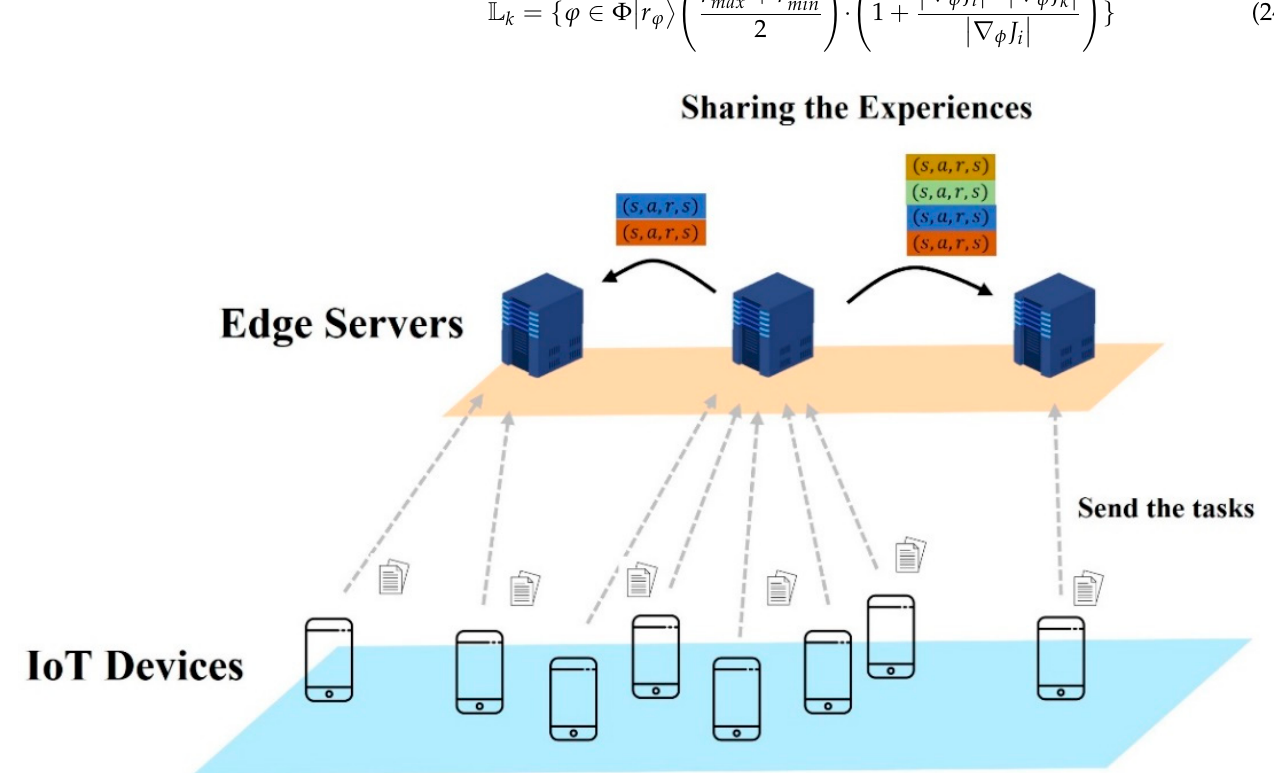
Figure 4. Example of experience sharing between agents. Algorithm 1 RL with Prioritized Experience Sharing